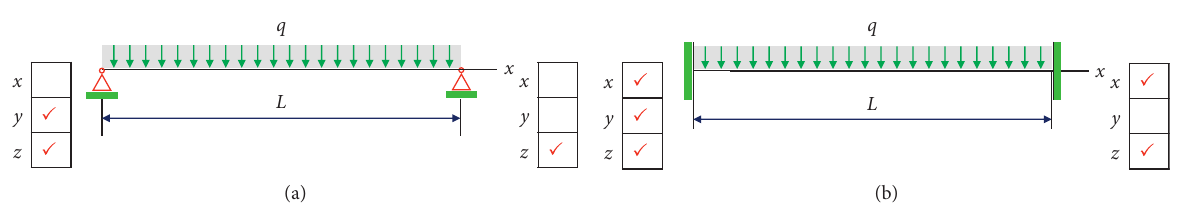
Figure 6: (a) Simply supported box girder subjected to uniformly distributed load. (b) Fixed-end box girder subjected to uniformly distributed